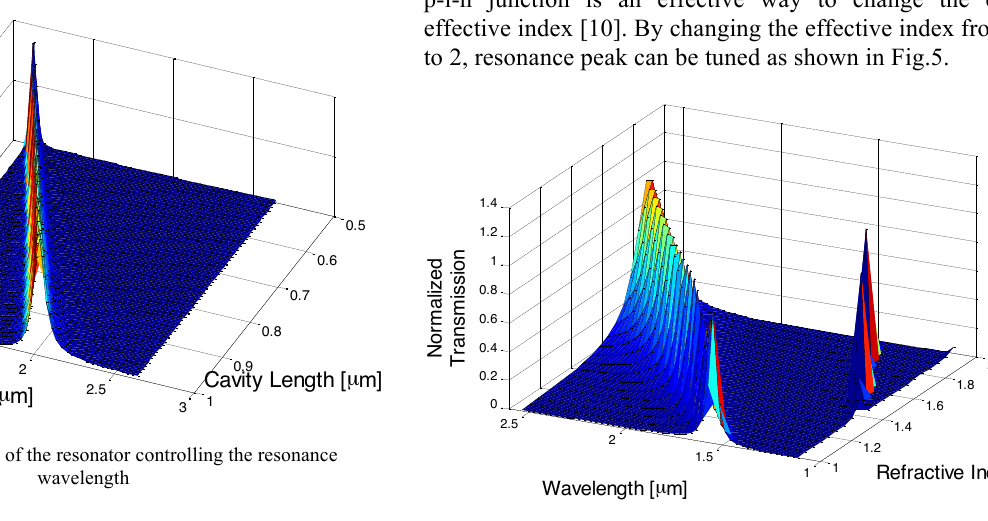
Fig. 5.The results of tuning the resonance wavelength electrically